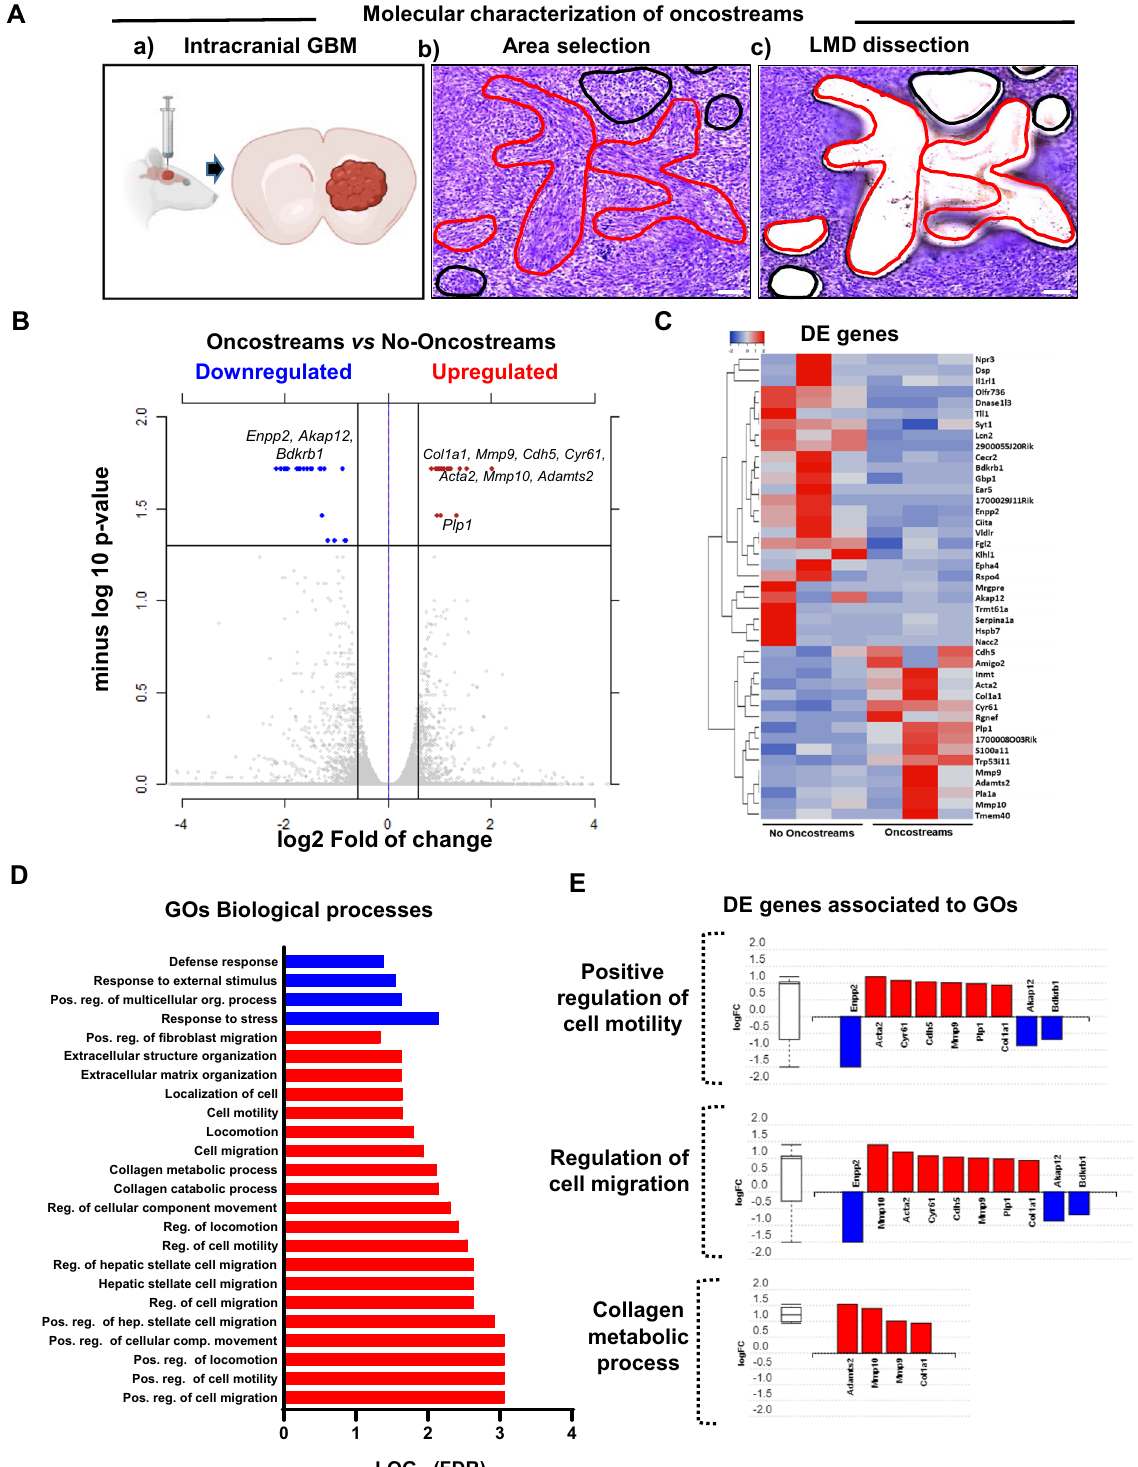
fl uorescent protein (GFP), within the thickness of each explant, was visualized using time-lapse confocal imagining and tracked using Fiji ’ s plug-in Track-Mate (Fig. 7A – C). Migration analyses show complex glioma cell dynamics throughout the tumor core. The glioma tumor core displays groups of cells (within particular zones) with similar nematic orientation and displaying complex movement patterns (Fig.